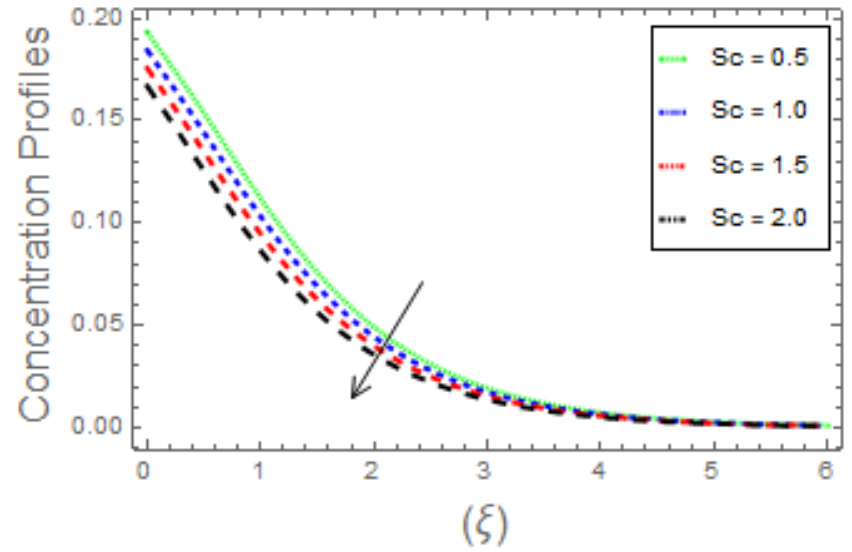
Figure 20. Variation in C due to Sc .